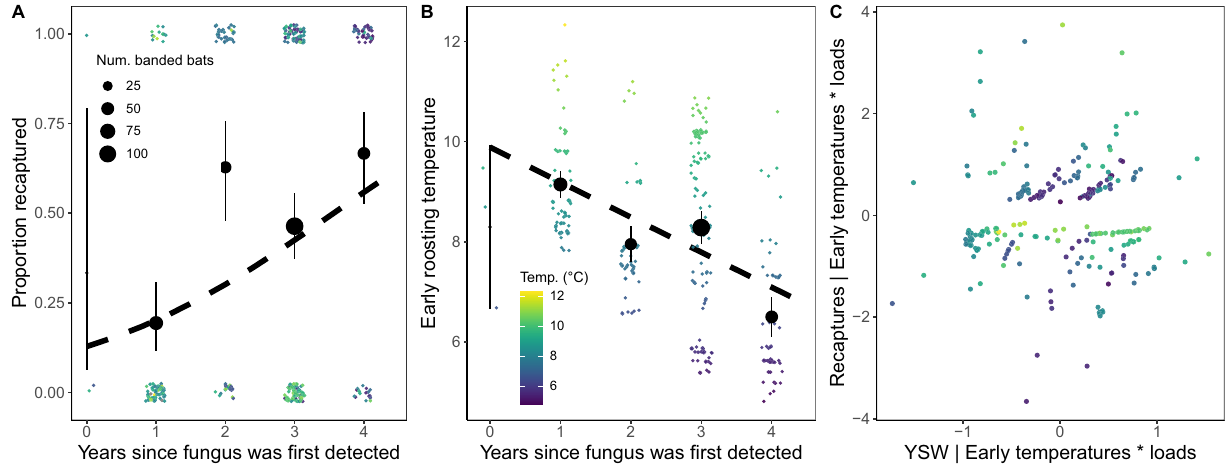
Fig. 5 Partial regression of recapture outcomes and invasion year. a Years since the detection of P. destructans at a site and proportion of infected, banded little brown bats ( n = 259) that were recaptured (black points + / − 95% Wilson binomial con fi dence intervals). The small points show the outcomes for individual bats (1 = recaptured, 0 = not recaptured) and the dashed line shows the best fi tting binomial GLM without accounting for changes in roosting temperature over time. b Years since the detection of P. destructans at a site and average early hibernation bat roosting temperatures ( n = 259 bats, black points + / − 95% Gaussian con fi dence intervals), which signi fi cantly negatively decreased across invasion years (also see Fig. 5). c Partial regression analysis of years since detection of the fungus (YSW) and bat recapture probabilities after accounting for early hibernation temperatures and fungal loads. After accounting for the change in bat roosting temperatures throughout invasion ( b ), there was no additional signi fi cant effect of fungal invasion year on recapture probabilities ( c